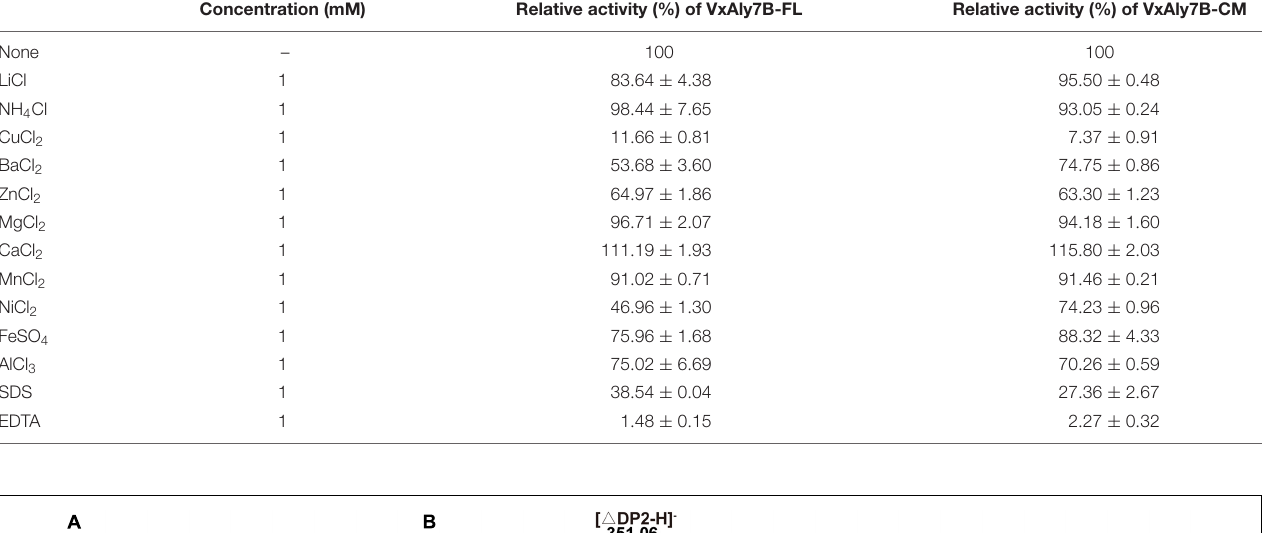
TABLE 3 | Effect of metal ions, chelators, and detergents on recombinant VxAly7B-FL and VxAly7B-CM. Concentration (mM) Relative activity (%) of VxAly7B-FL Relative activity (%) of VxAly7B-CM